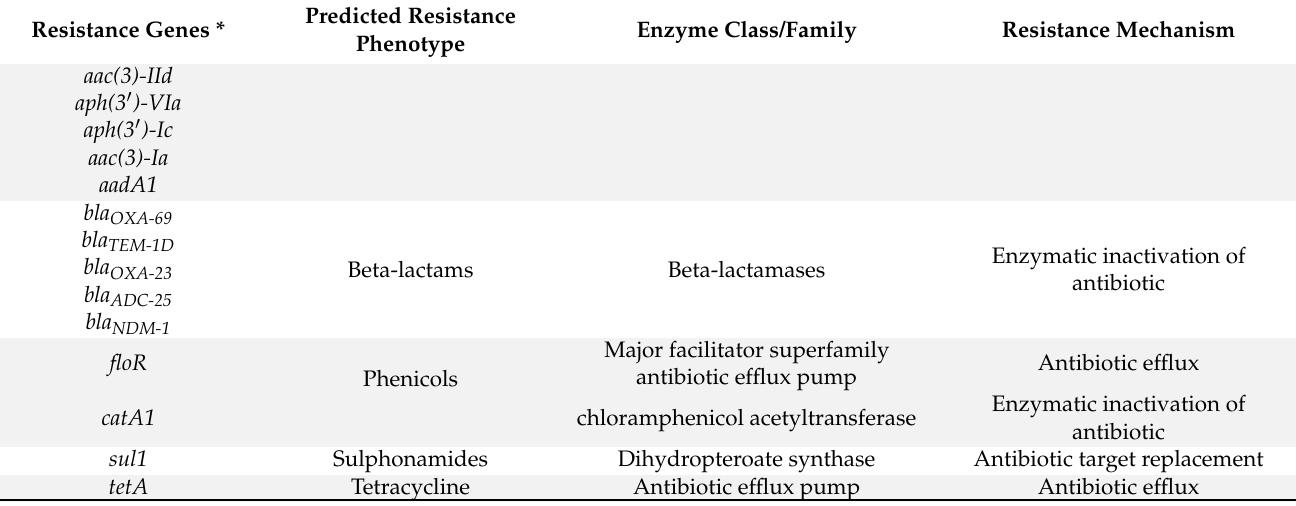
Table 2. Antimicrobial resistance genes revealed by ResFinder analysis in A. baumannii